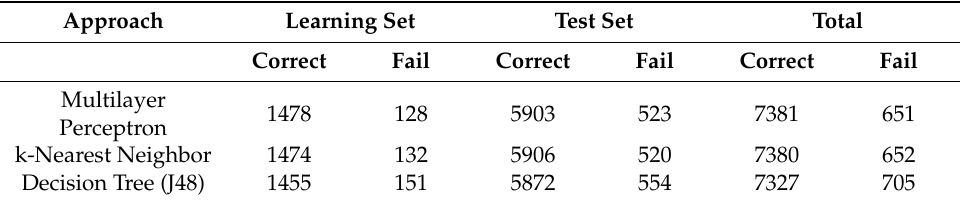
Table 4. Recognizing location, L f , of individual in frame.